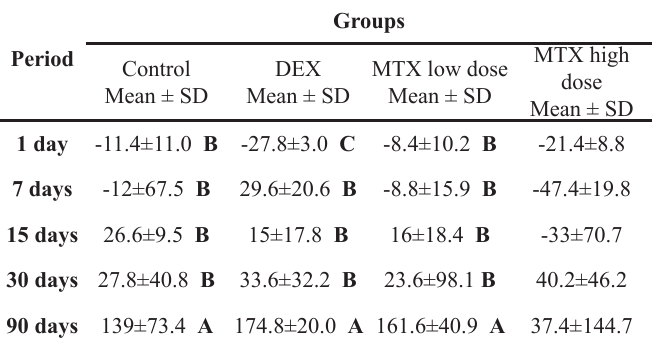
TABLE 1 - Mean values and standard deviations (SD) of the rate of gain or loss of weight (g) and significance of Tukey´s